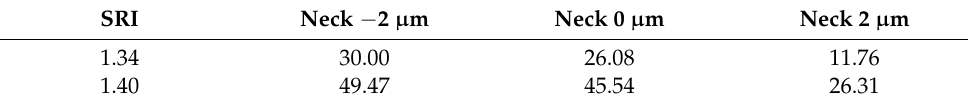
Table 2. FOM (RIU − 1 ) for a thin-film thickness of 125 nm.